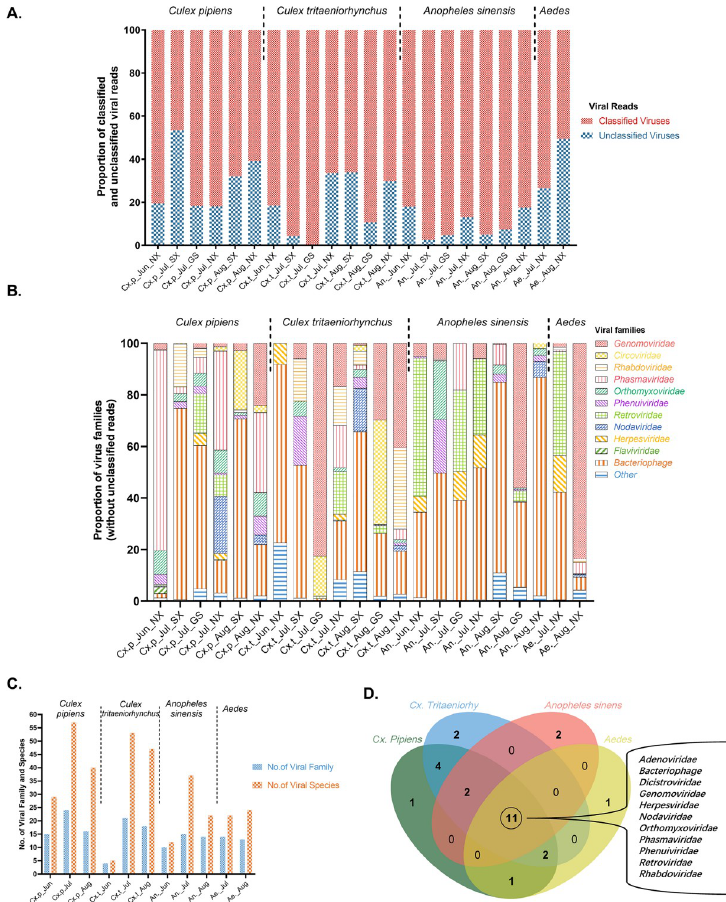
Fig 2. Virome of mosquitoes in the Shaanxi-Gansu-Ningxia region. A. Proportions of classified and unclassified viral reads. Each bar represents a mosquito pool, as described in Table 1. B. Proportions of viral families among the classified viral reads. Each bar represents a mosquito pool, as described in Table 1. Read percentages lower than 0.1% are grouped as Others. C. Number of viral families and species among mosquitoes sorted by mosquito species and collection month. D. Venn diagram showing viral families found in the four mosquito groups. The four mosquito groups are presented in separate areas of the diagram. The numbers are representative of viral families found in mosquitos of each